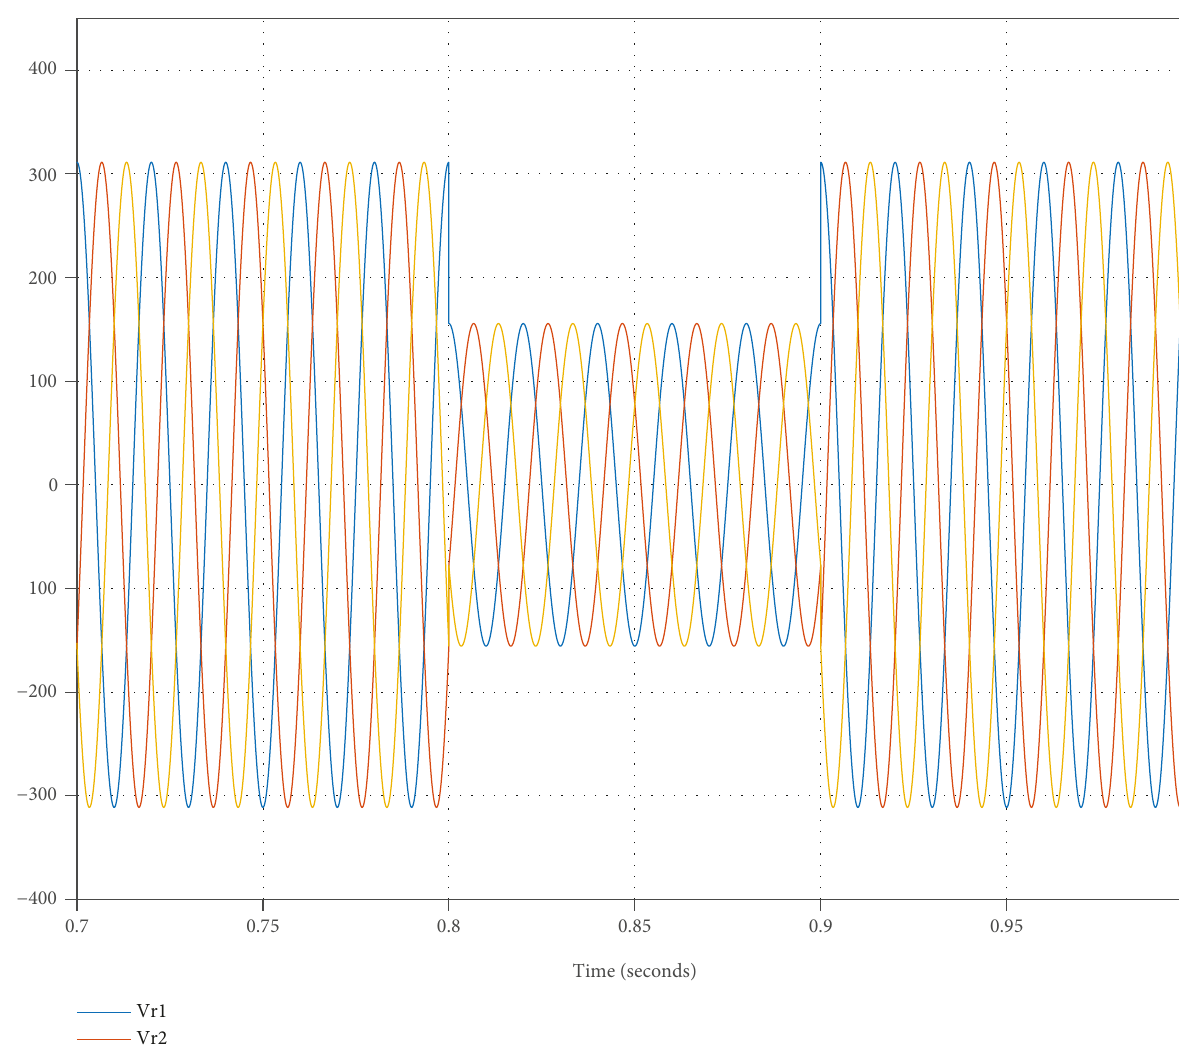
Figure 16: Voltage dip at t = 0 8s, 0 9 s